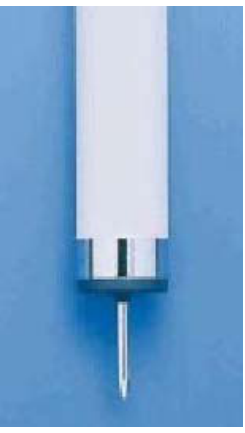
Figure 1. The HMS 9000 electrode